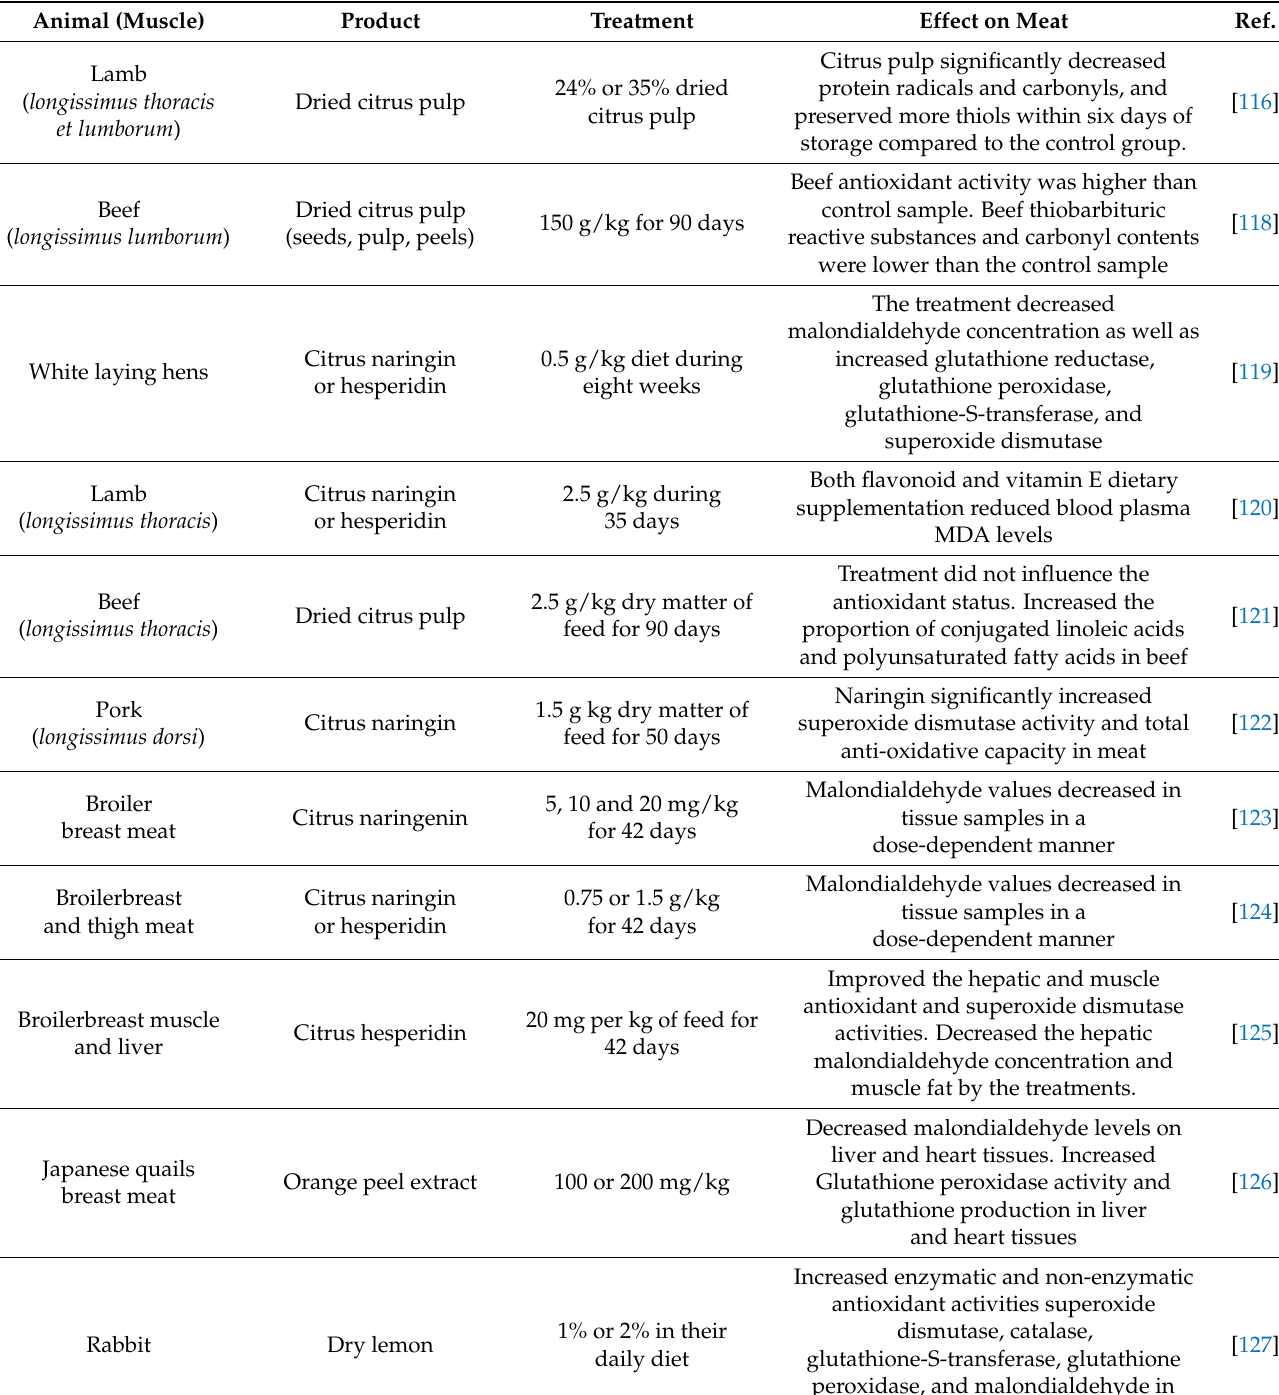
Table 4. Effects of citrus flavonoid-rich feed sources and crude citrus extracts on fresh meat